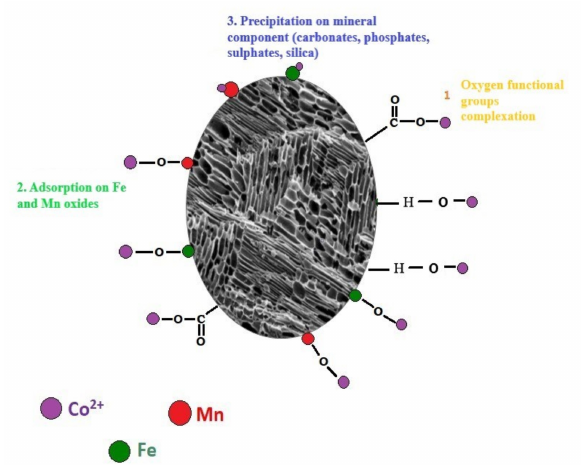
Figure 4. Conceptual model of Co adsorption mechanism on wheat straw biochar